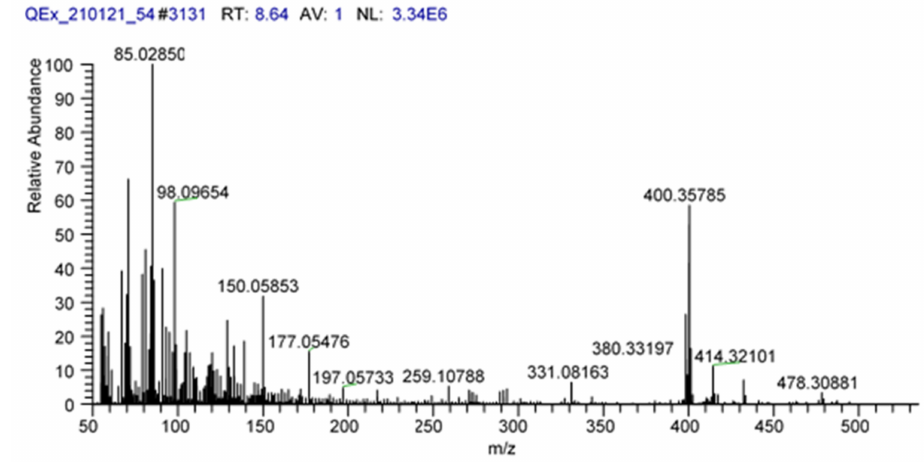
Figure A4. Spectrum of presumed AfB 1 + H 2 SO 4